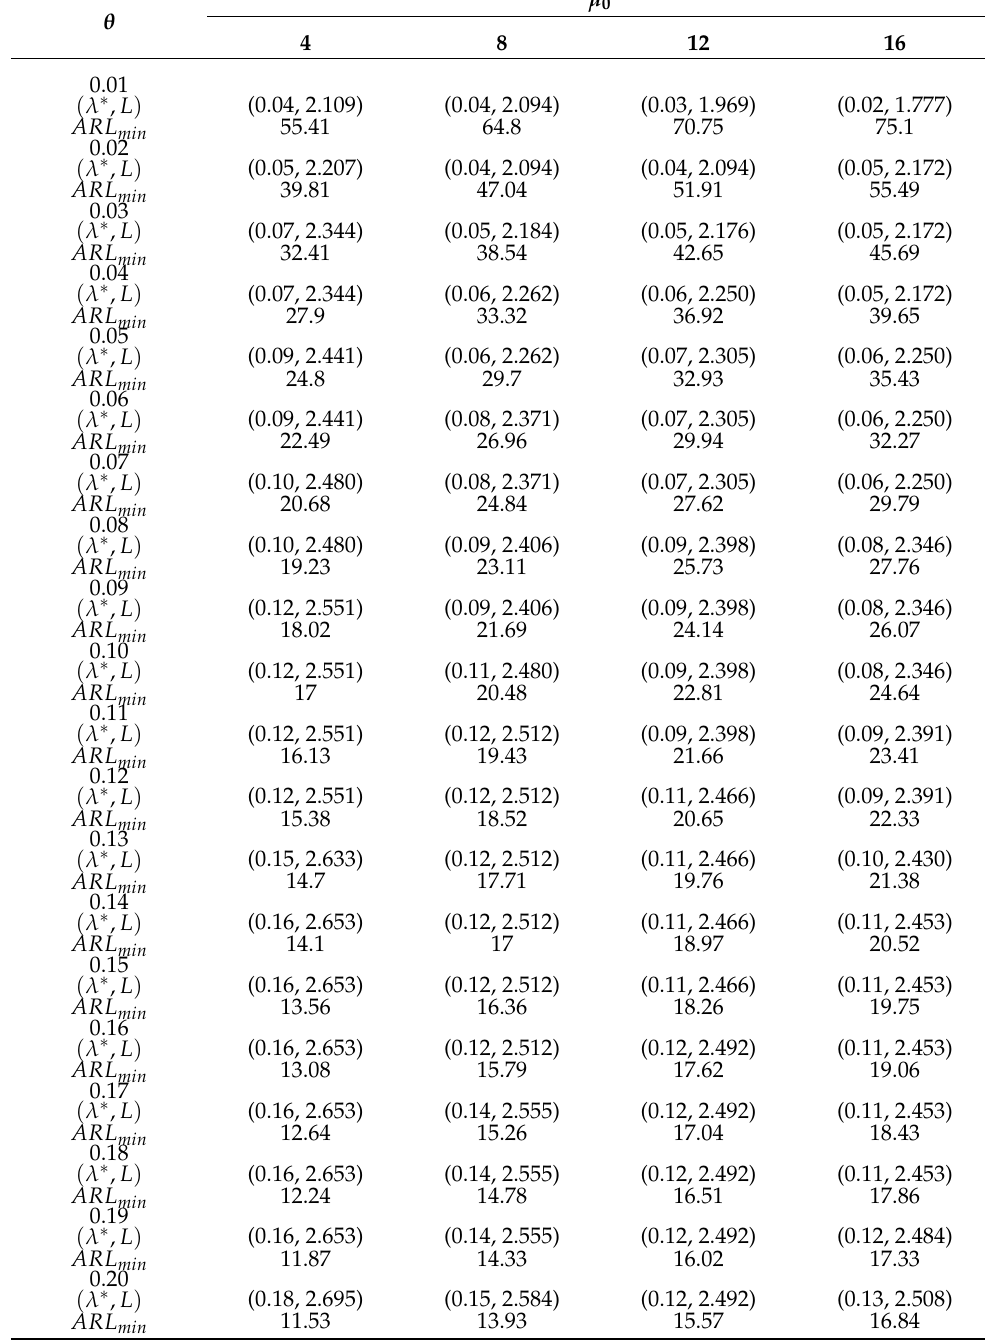
Table 3. Optimal parameters for the EWMA chart when ARL 0 =